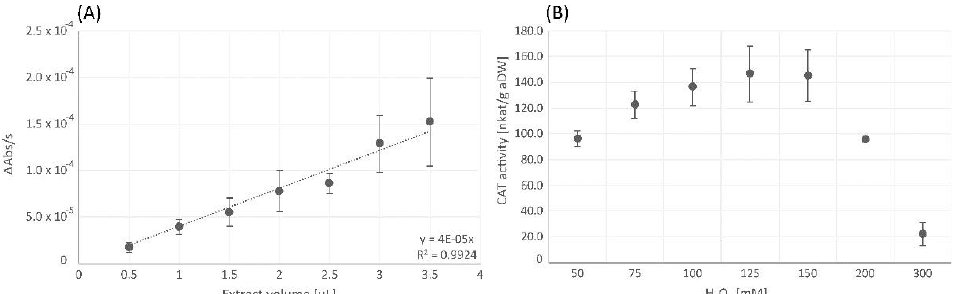
Figure 4. Dose-dependent linearity of catalase (CAT) assay, performed with the original substrate concentration of 100 mM according to Fimognari et al. [43] ( A ) and variation of the substrate (H 2 O 2 ) concentrations for catalase (CAT) assay ( B ). Changes in absorbance per second [ ∆ Abs/s] ( A ) and CAT activity [nkat/g aDW] ( B ) are shown as mean values ± standard deviation (n = 3). The negative values resulting in the decrease of absorbance were multiplied by − 1 to receive positive values.